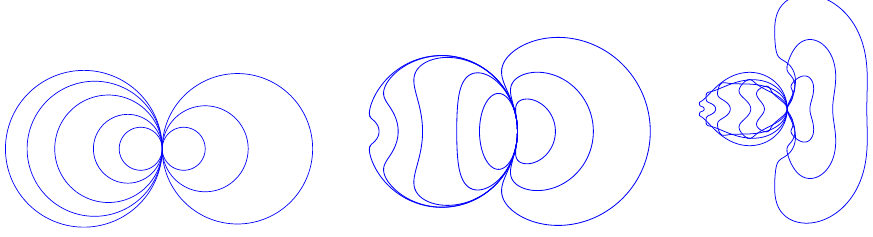
Figure 1 . We show three sets of entangling regions (left, middle and right plots, respectively). In each set, all the different regions are related to each other through conformal transformations (the same transformations are applied in each set), and therefore share the same F for a given CFT. Disks are naturally unchanged, but notice for instance how an ellipse (innermost figure in middle plot) can be deformed, without modifying F , into a disk with a small